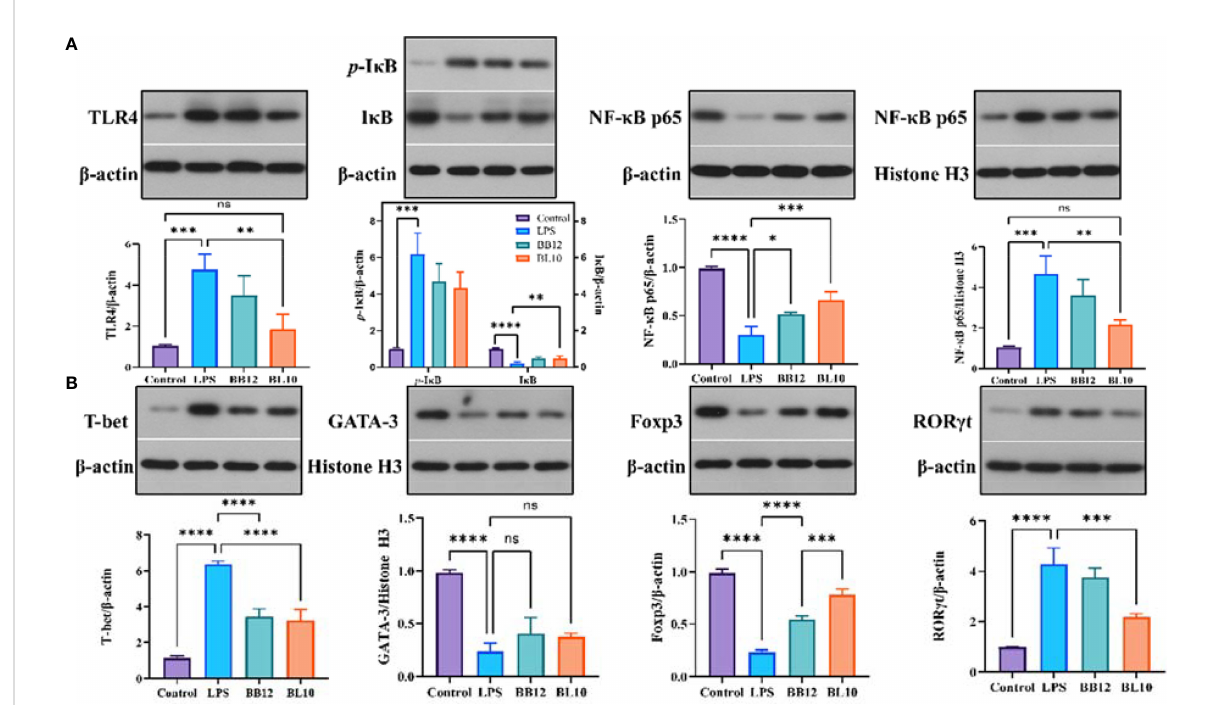
FIGURE 7 Effect of B. longum BL-10 on gut microbiota composition. (A) PCA; (B) Gut microbial changes at the phylum level; (C) Gut microbial changes at the genus level; (D) Prediction of the gut microbiota function; (E) Correlation analysis about gut microbial alteration. All data are expressed as